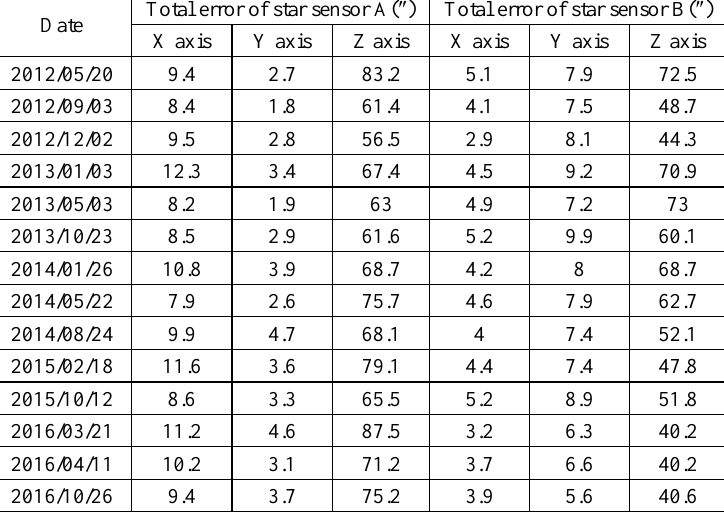
Table 1. Standard deviation using single star sensor attitude difference method